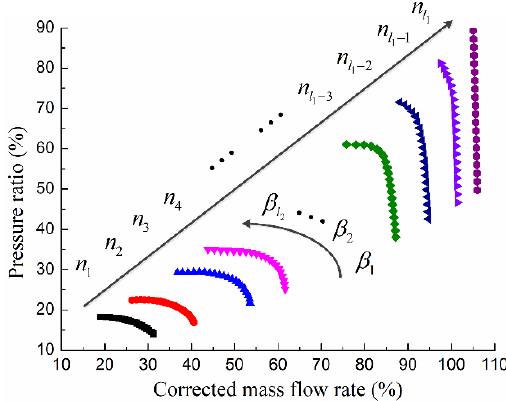
Figure 2. A typical map of an axial compressor.